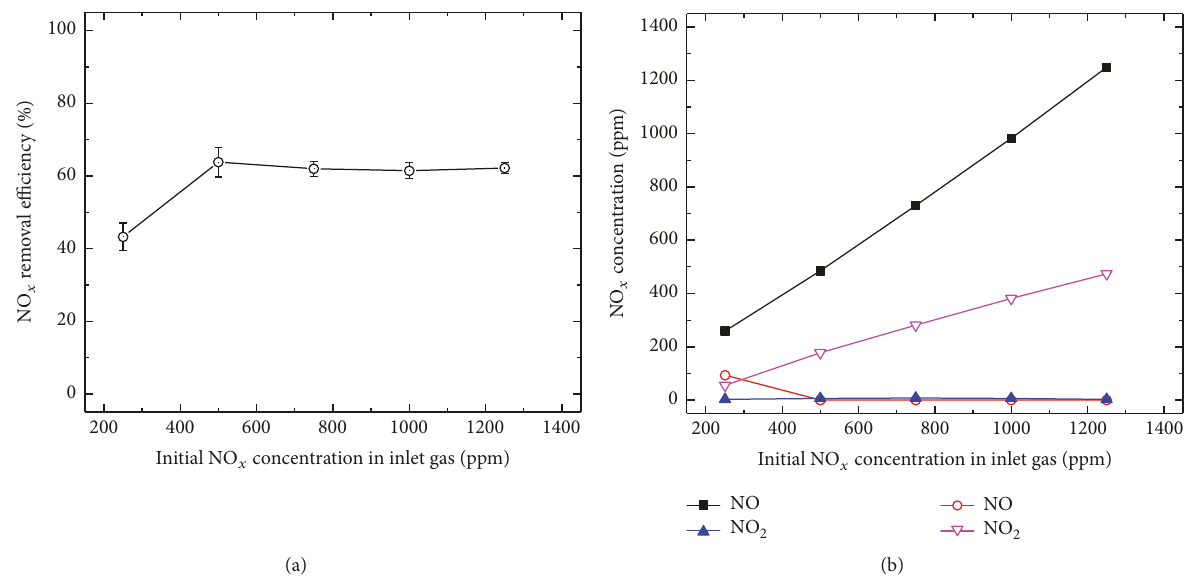
Figure 11: The change of (a) NO removal efficiency and (b) NO 𝑥 concentrations with the initial NO x inlet NO concentration is 250–1250 ppm, NaClO concentration is 0.05 M, initial solution pH is 6, and solution temperature is 293 K; solid x points refer to inlet NO concentrations and open points refer to outlet NO x